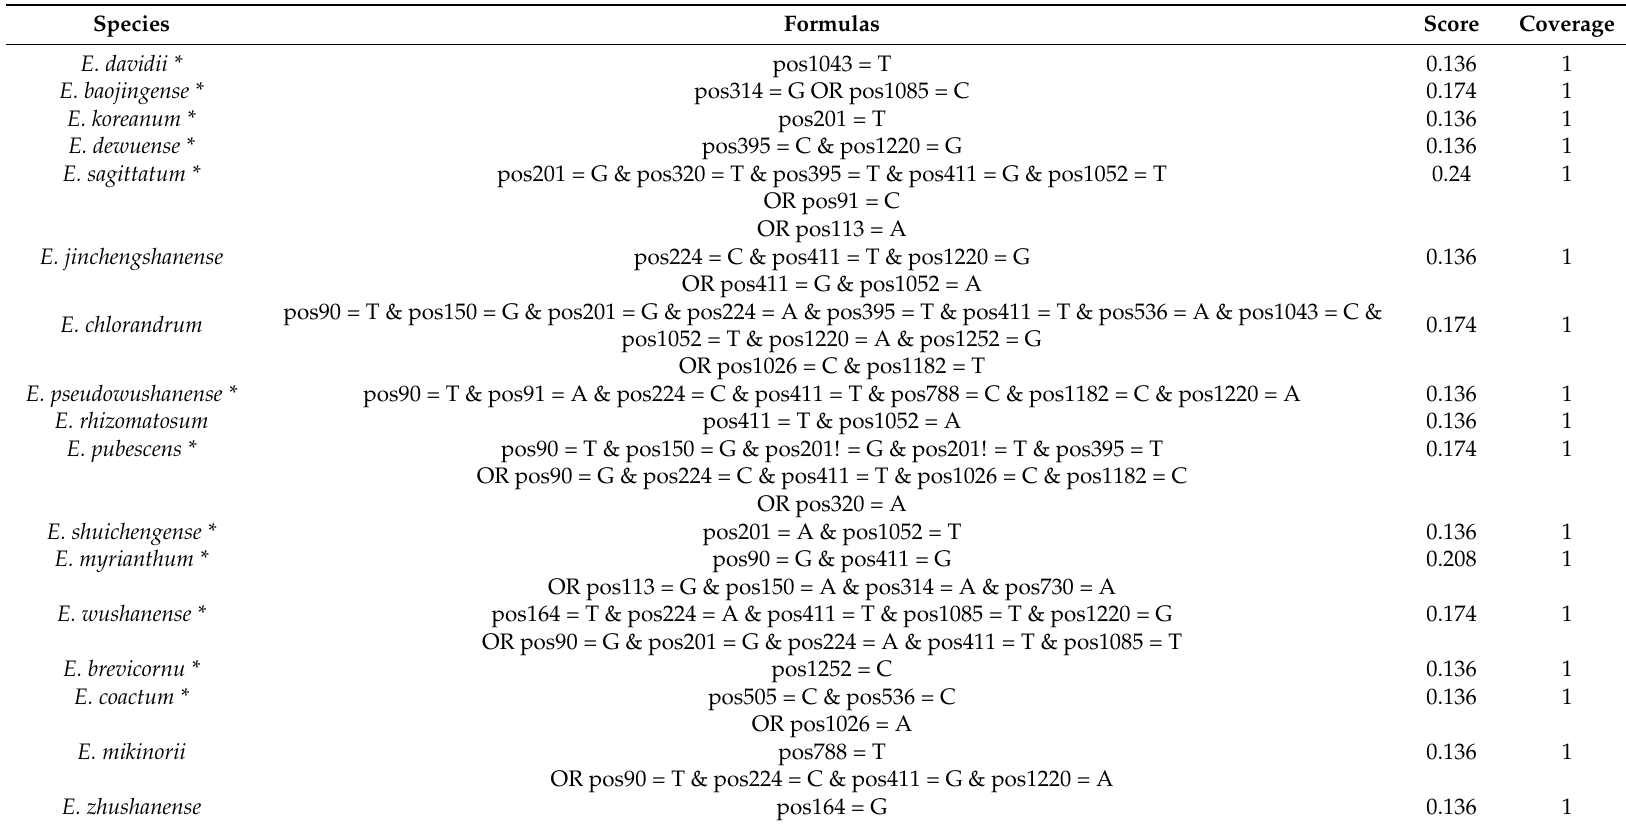
Table 2. Diagnostic formulas of psbA-trnH + ITS region generated by BLOG for species identification. “*” represents medicinally used